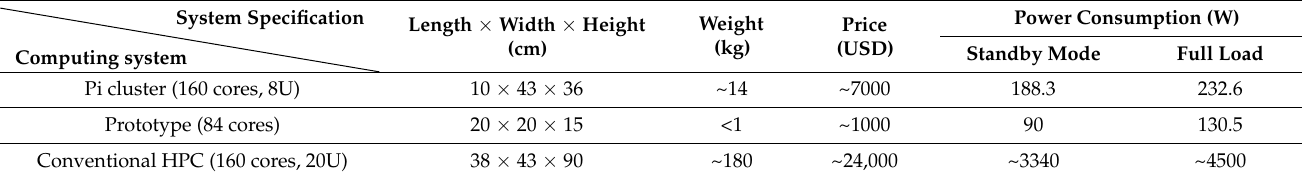
Table 1. Each computing system’s system specifications, price, and power